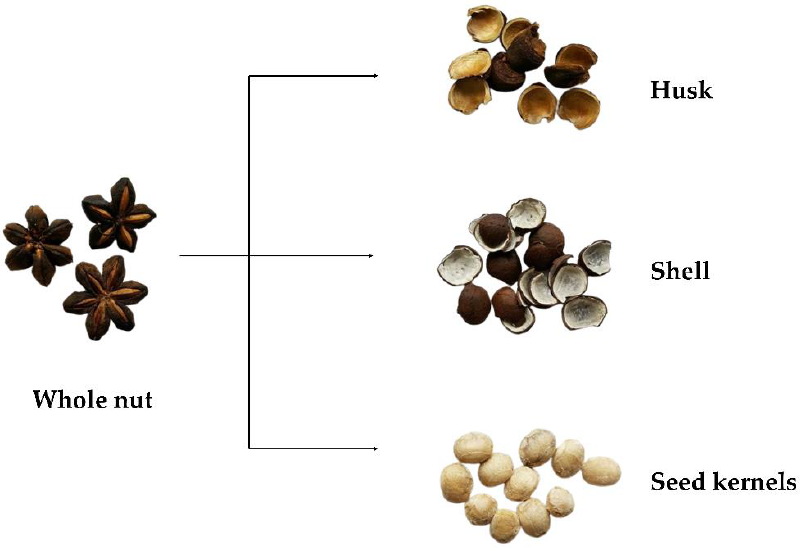
Figure 1. The physical appearances of the husk and shell of sacha inchi. The extraction was performed using the powdery sample (0.2 g) in 20% ( v/v ) aqueous ethanol (100 mL). The mixture was incubated in a 70 °C WNE45 water bath shaker (Memmert GmBh, Eagle, WI, USA) for 15 min. After centrifugation at 3800 × g for 10 min in a Hettich ® ROTINA 38R centrifuge (Andreas Hettich GmbH, Tuttlingen, Germany), the supernatant was collected, and the clear extract was received by filtering the supernatants through a 0.45 µM polyether sulfone (PES) membrane syringe filter.